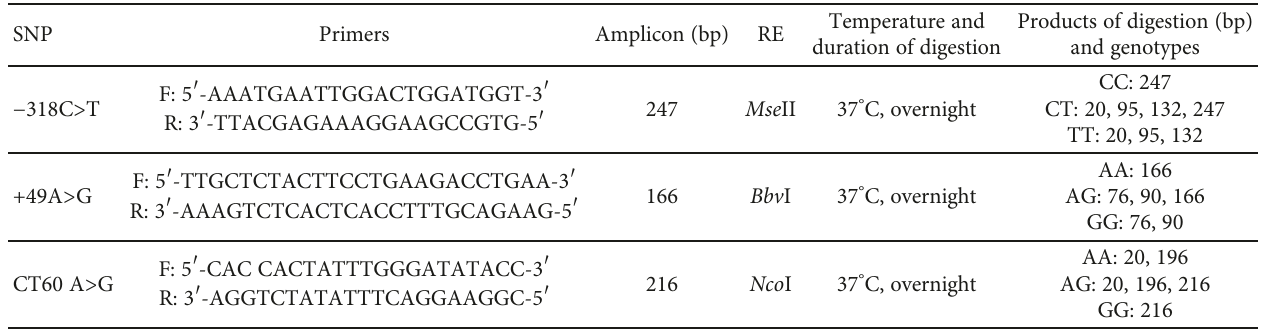
Table 2: Primers, conditions for digestion, products of digestion, and genotypes according to products of digestion. SNP